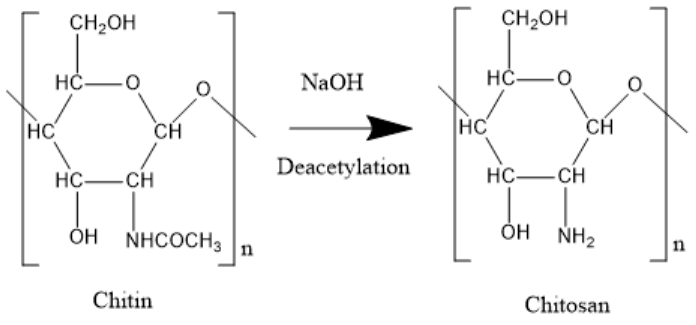
Figure 8. The scheme of conversion of Chitin to Chitosan.